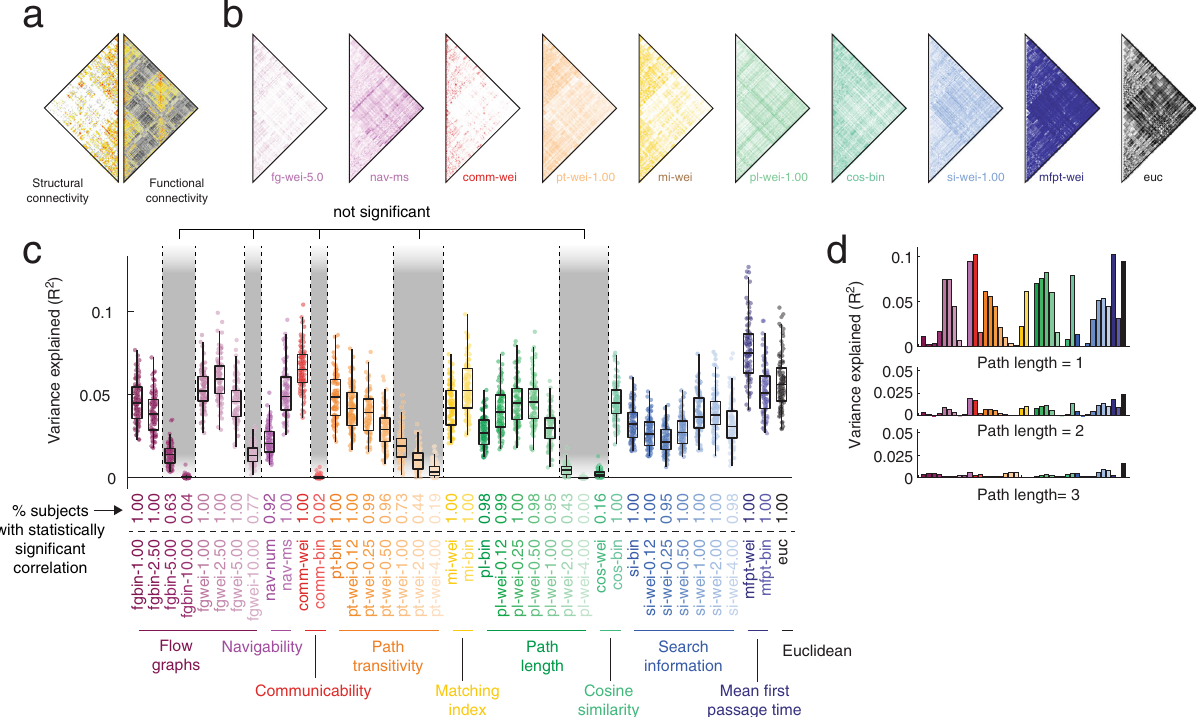
Fig. 1 Whole-brain functional connectivity is heterogeneous and not fully explained by any factor. a Whole-brain structural and functional connectivity data from the HCP dataset. b We used a series of dynamic, topological, and geometric models to transform sparse SC matrices into fully-weighted matrices (predictors). Here, we show examples: fl ow graphs ( fg-wei-5.0 ), navigation ( nav-ms ), communicability ( comm-wei ), path transitivity ( pt-wei-1.00 ), matching index ( mi-wei ), path length ( pl-wei-1.00 ), cosine similarity ( cos-wei ), search information ( si-wei-1.00 ), mean fi rst passage time ( mfpt-wei ), and Euclidean distance ( euc ). Note that here and in all other fi gures, we adopt a consistent color scheme, wherein data associated with a given predictor, e.g. same measure but different parameters or weighted/binary versions of a measure, are depicted using variation of the same color. For example, communicability measures are red, matching index is yellow, and mean fi rst passage time is dark blue. c Variance in whole-brain FC weights explained by factors. Each point represents a subject ( N sub = 70 subjects following exclusion for motion and data quality; FC and SC averaged over two scan sessions). In each boxplot, the “ box ” denotes interquartile range (IQR), the horizontal bar indicates the median value, and the whiskers include points that are within 1.5 × IQR of upper and lower bounds of the IQR (25th and 7th percentiles). Any points that fall beyond the whiskers are, by convention, considered outliers. d Decreases in variance explained as a function of path lengths (hops). Source data are provided as a Source Data fi